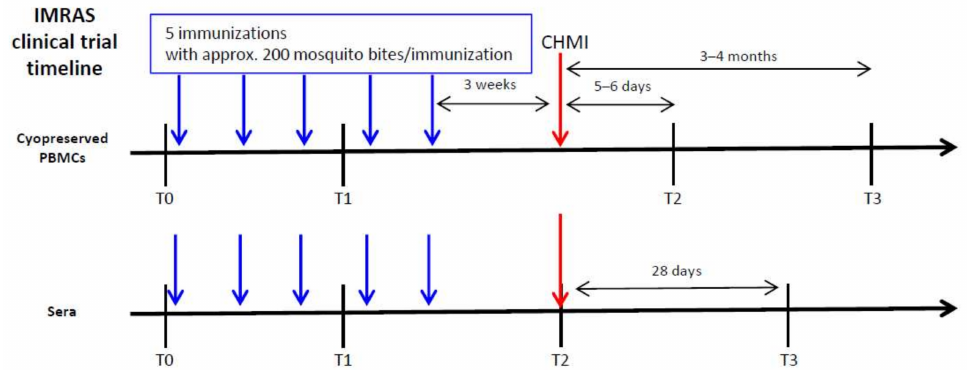
Figure 1. IMRAS clinical trial timeline. Cryopreserved PBMCs were available from baseline (T0), 2 weeks after the third immunization (T1), 5–6 days after controlled human malaria infection